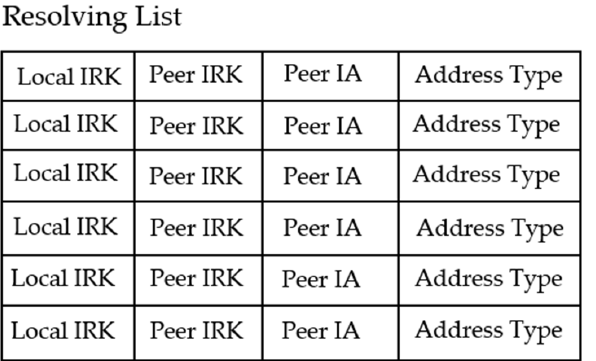
Figure 3. Initial connection procedure.